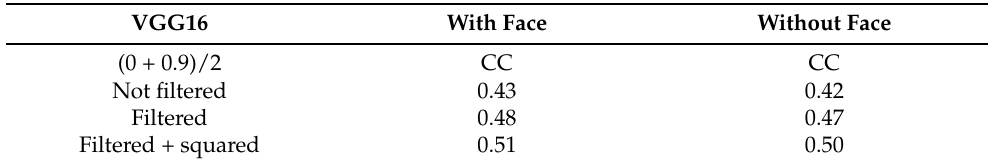
Table 4. The MIT1003 dataset. Tests on threshold 0 and 0.9 by considering the saliency map without filtering, with filtering, and with filtering and squared. VGG16 With Face